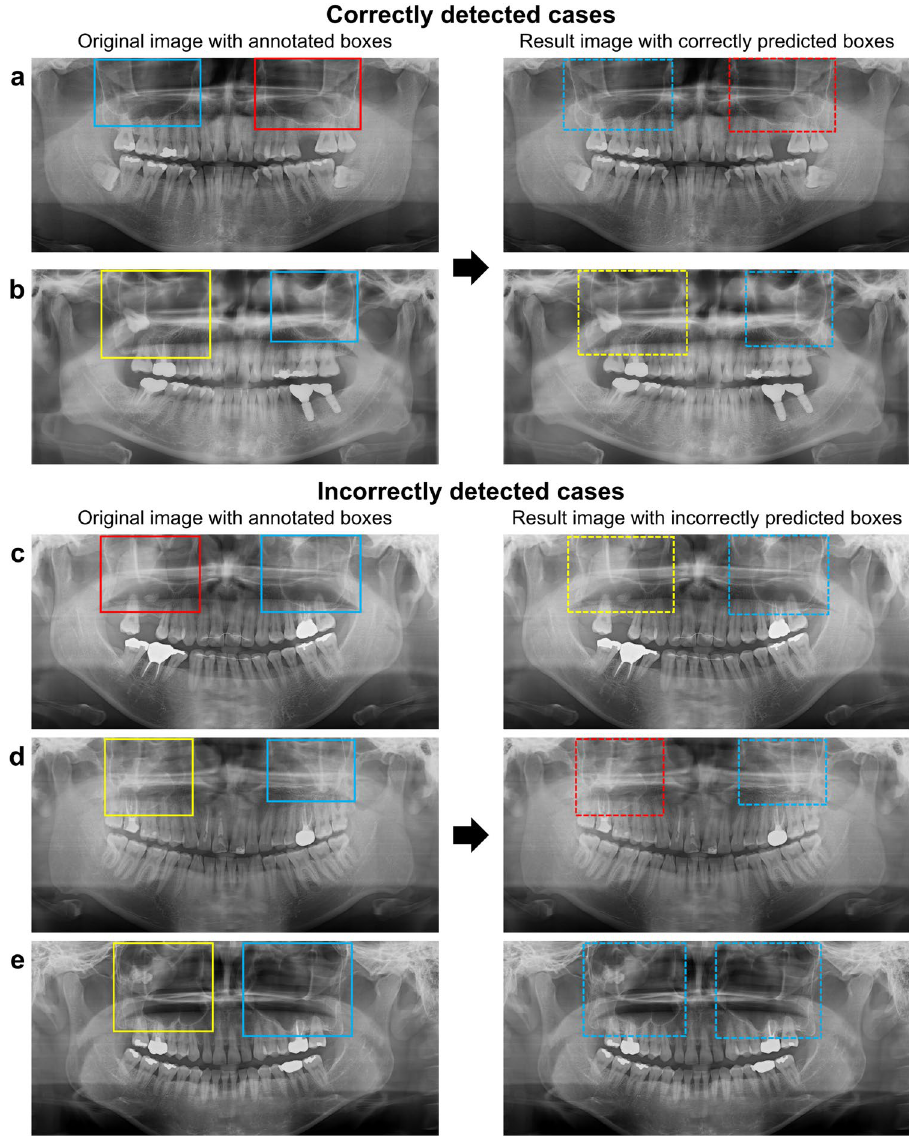
Figure 3. Examples of sinuses classified by the model. The left side of each case is the original panoramic radiograph with annotated boxes (solid line) and the right side of each case is the resulting panoramic radiograph with predicted boxes (dotted line) in a different color for each class (healthy: blue, retention pseudocyst: red, cyst or tumor: yellow). Examples of sinuses detected by the model with correct classes ( a , b ). Examples of sinuses detected by the model with incorrect classes ( c – e ). In the right maxillary sinuses, a retention pseudocyst was incorrectly predicted as a cyst or tumor ( c ), a cyst or tumor was incorrectly predicted as a retention pseudocyst ( d ), and a cyst or tumor was incorrectly predicted as healthy ( e